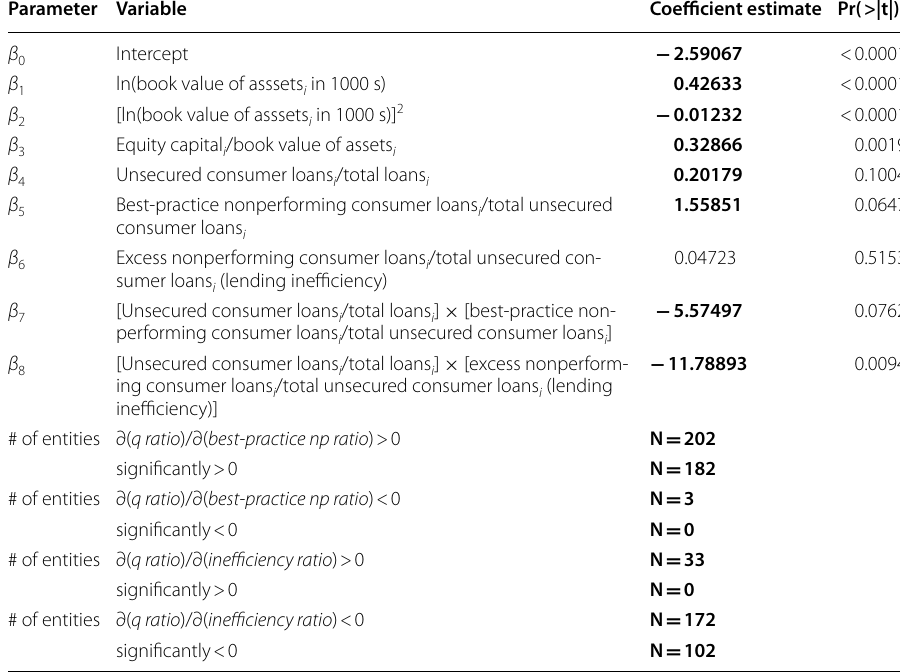
Table 11 2016 relationship of financial performance measured by Tobin’s q to the ratio of nonperforming unsecured consumer loans decomposed into the Best‑Practice Ratio and the Ratio in Excess of Best Practice (Lending